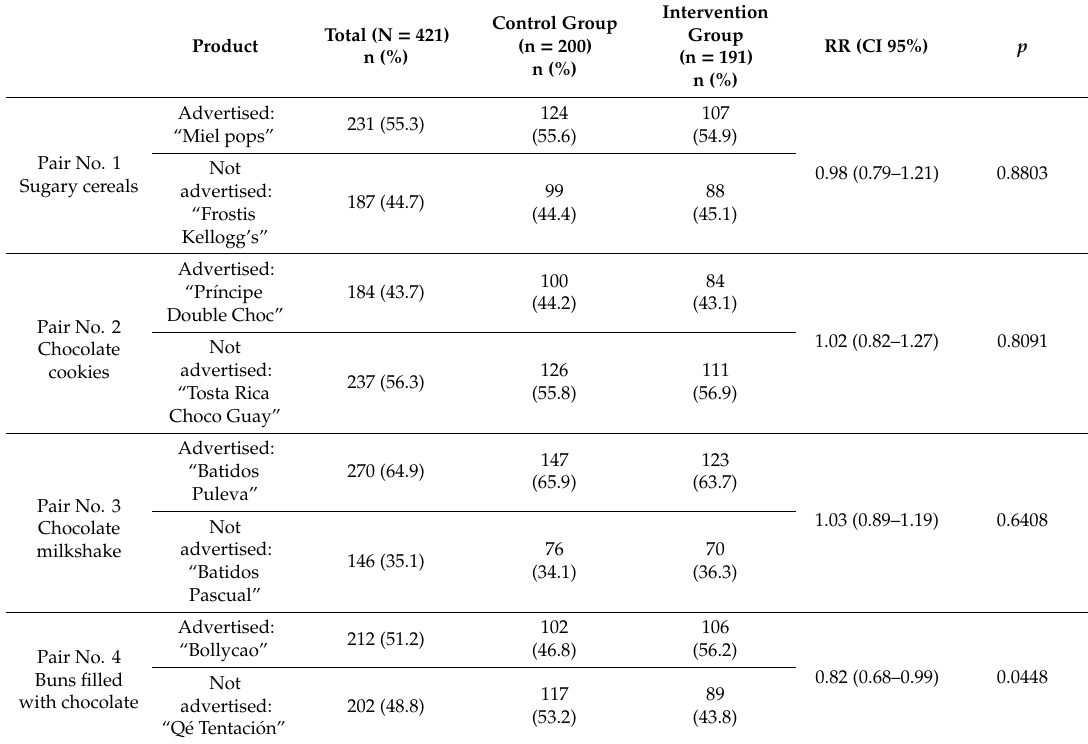
Table 1. Distribution of consumption preferences for the sample as a whole and bivariate analyses by